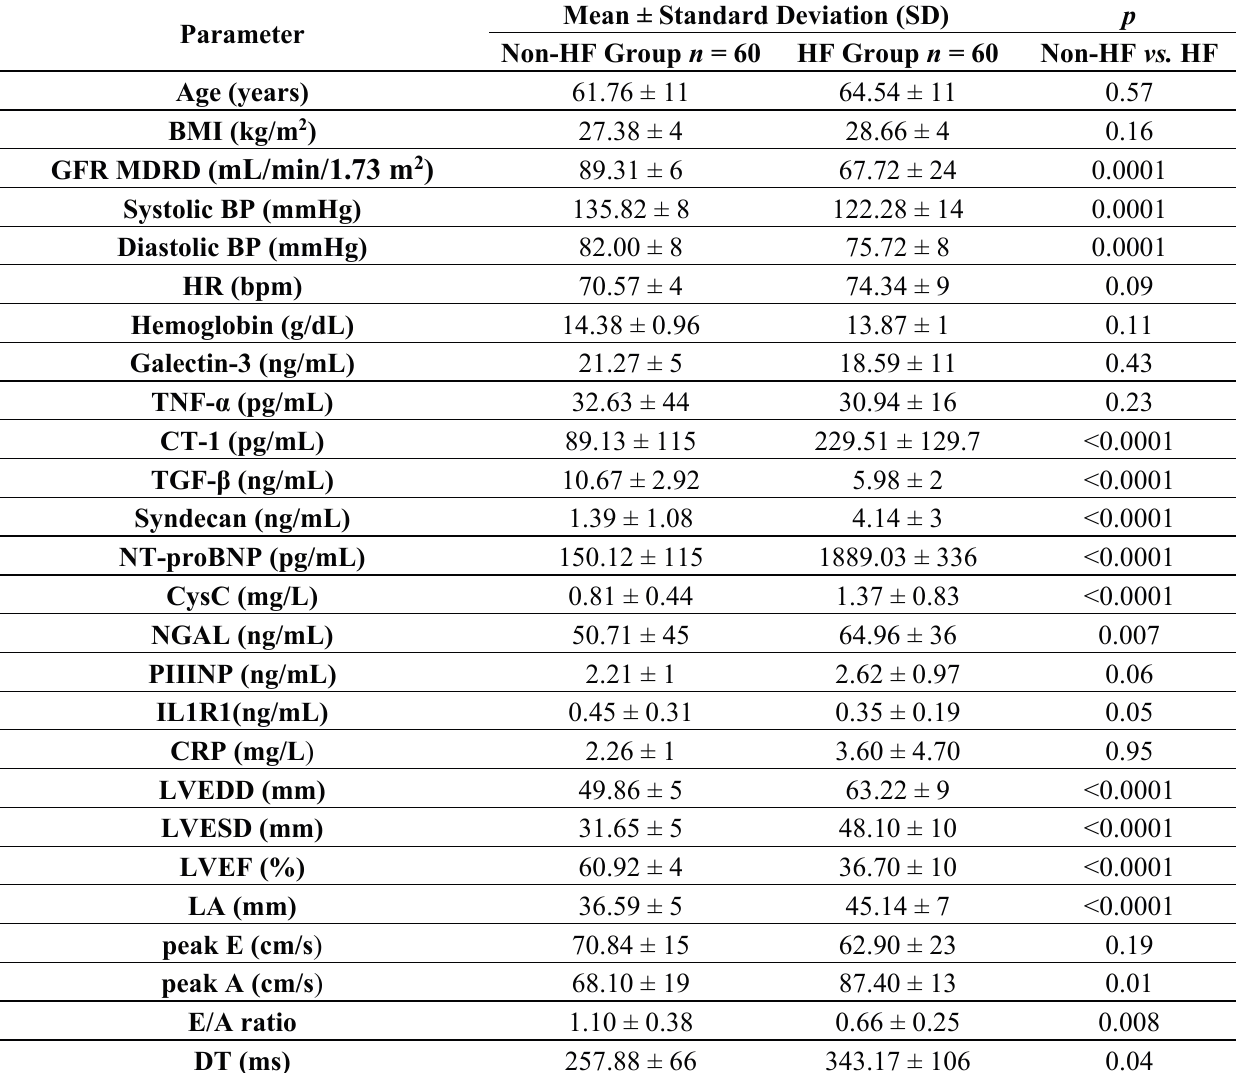
Table 1. Characteristics of patients and standard echocardiographic parameters in each